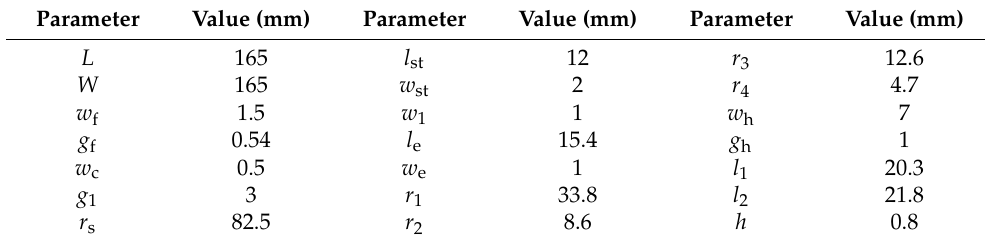
Table 1. Parameters of the proposed miniaturized wideband loop antenna.